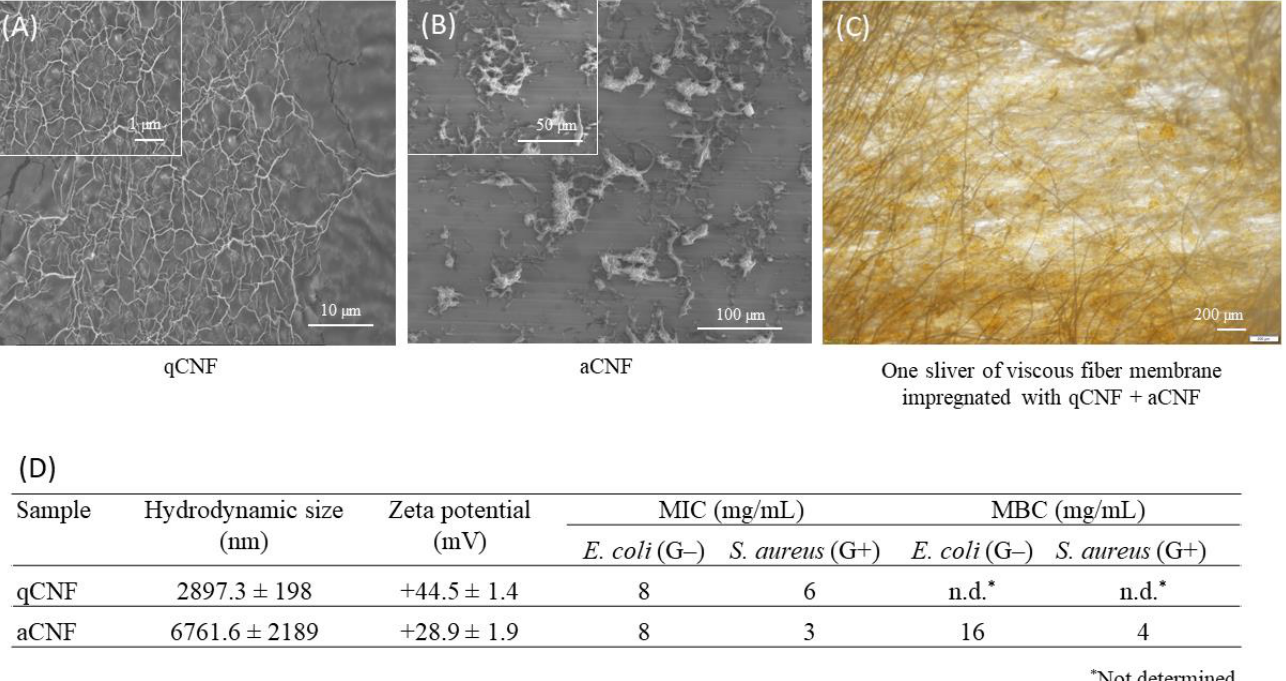
Figure 1. Selected data on the characterisation of the quaternised cellulose nanofibrils (qCNF) and amino-hydrophobised cellulose nanofibrils (aCNF) dispersed (0.01 wt%) in milli-Q water (pH 6.7): ( A , B ) SEM micrographics, ( D ) hydrodynamic size, and ( D ) zeta potential. ( D ) Minimum inhibitory (MIC) and minimum bactericidal (MBC) concentrations of the qCNF and aCNF suspensions for Gram-negative (G − ) bacterium Escherichia coli (EXB-V127) and Gram-positive (G+) bacterium Staphylococcus aureus (EXB-V54) were determined by the broth macrodilution antibiogram method. ( C ) The optical image presents the dense matrix of viscous fibres and CNF in one sliver, that was isolated from the one-layer membrane impregnated with 0.1 wt% qCNF and 0.3 wt% aCNF.